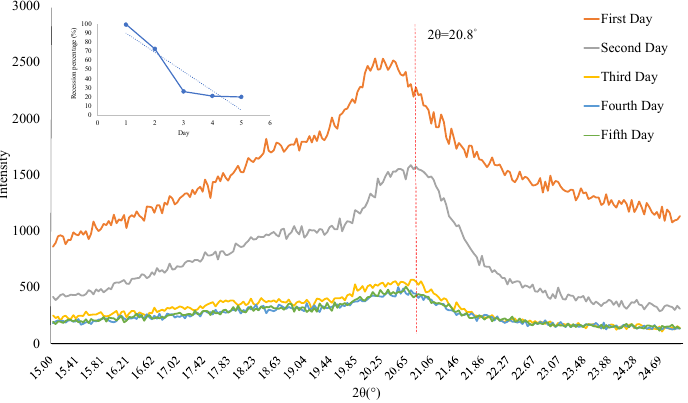
Figure 6. XRD pattern for self-powered strain sensors.